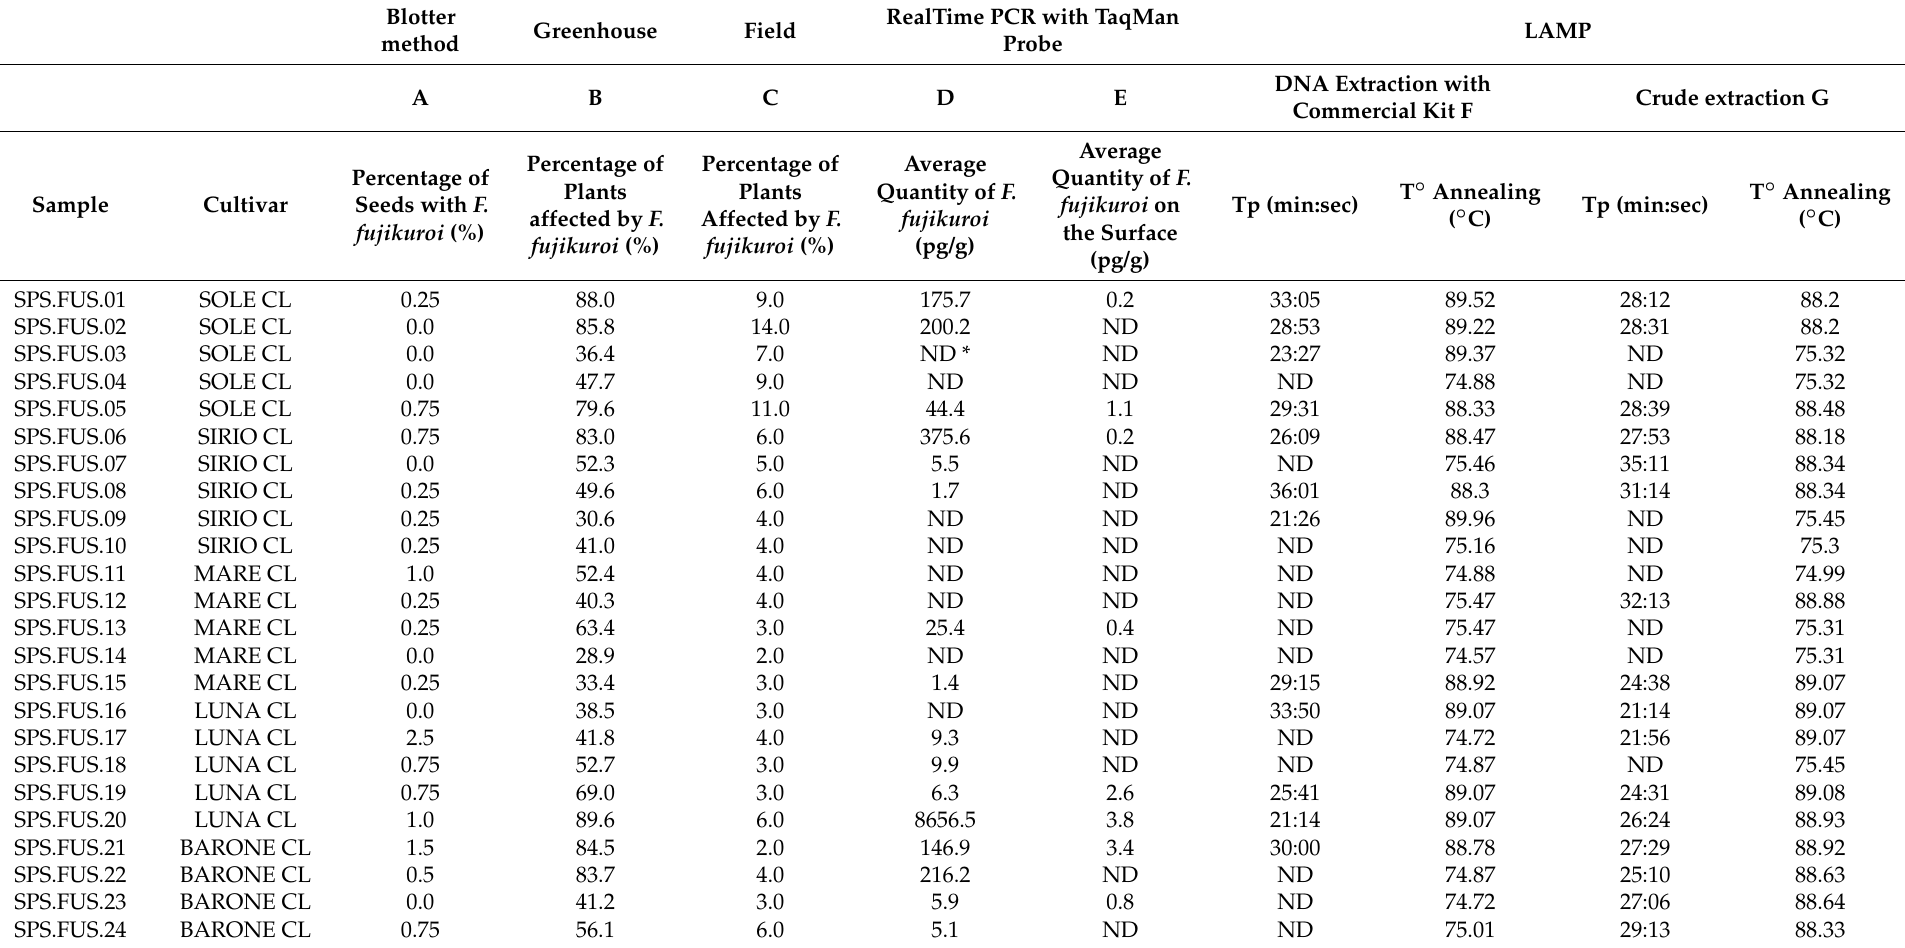
Table 2. Percentage of seeds and plants infected with F. fujikuroi observed with blotter method (A), in the greenhouse (B) and in the field (C), in the 34 seed lines used in this study. Quantitation (pg/g) of F. fujikuroi in the seeds (D) and on their surface (E) with RealTime PCR with TaqMan probe and amplification with LAMP assay (Tp and T ◦ annealing) of F. fujikuroi extracted by the seeds with commercial kit (F) and with crude extraction (G). * ND = not